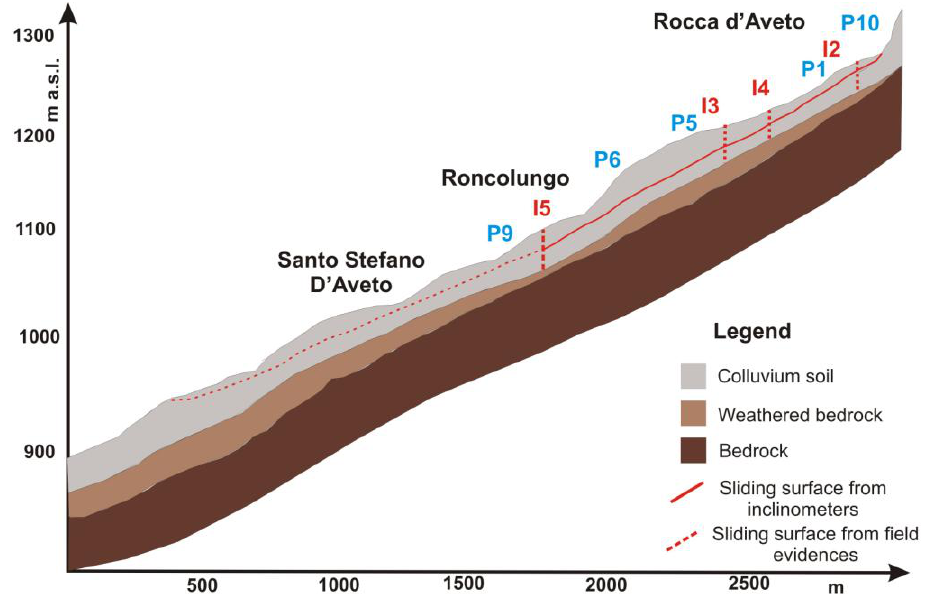
Figure 3. Geological section of the Santo Stefano d’Aveto